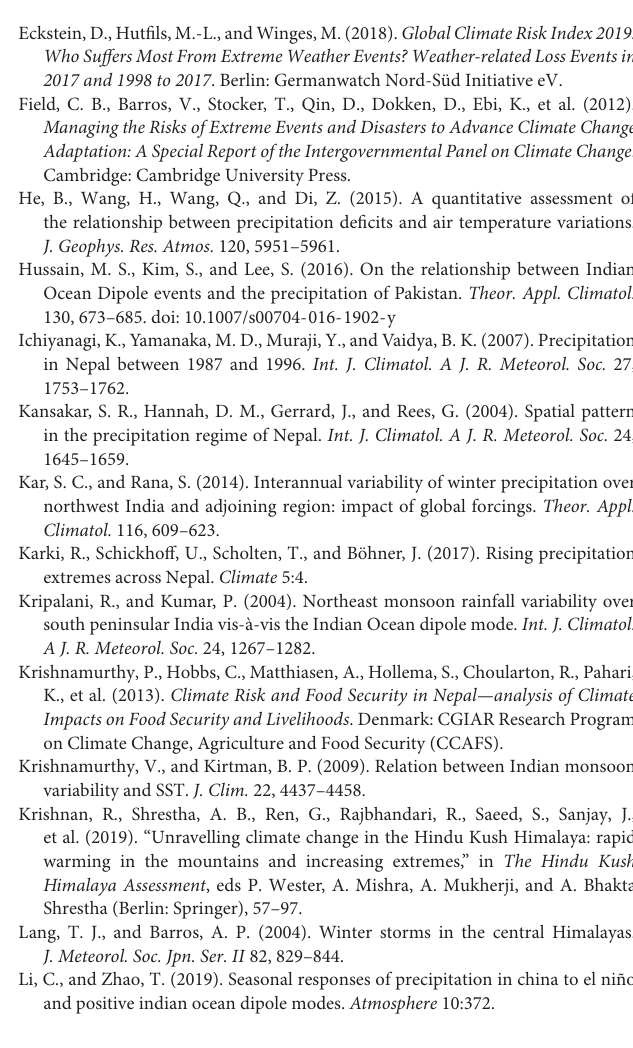
FIGURE S1 | Correlation between averaged winter precipitation and 2 m surface air temperature during 1987–2015, based on ERA5 data. The dotted points represent the significance at a 95% confidence